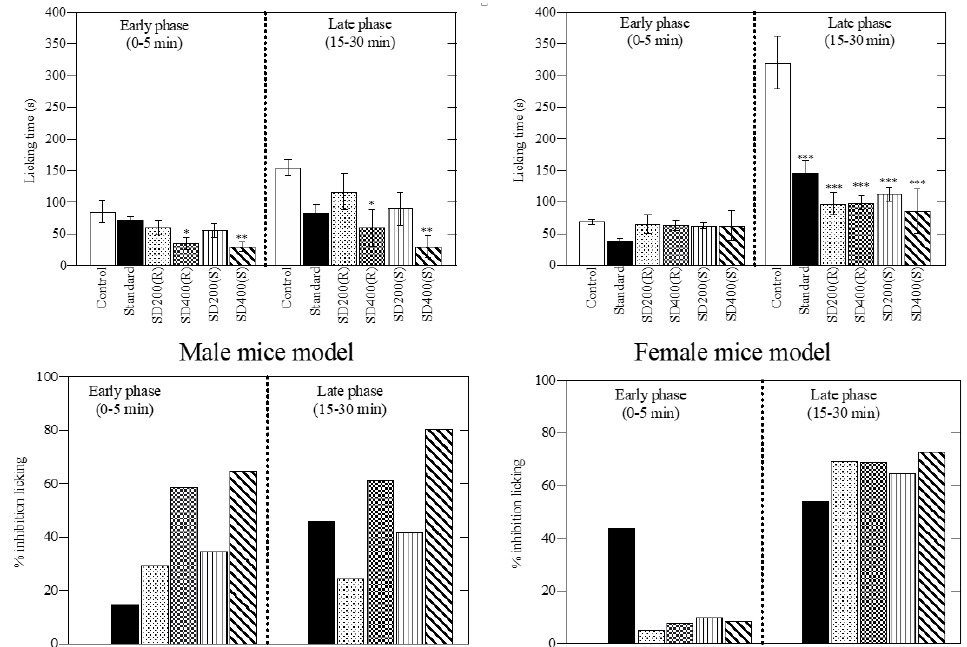
Figure 1. Effect of rhizome and stem extract of Schumannianthus dichotomus in formalin induced hind paw licking test in male and female mice model. Data were presented as Mean ± SEM. One-way ANOVA with Dunnett multiple comparisons test was performed to determine statistical significance of test results; here, *p<0.05, **p<0.01 and ***p<0.001 vs control. Table I. Effect of methanol extract of rhizome and stem of S. dichotomus on the number of writhing responses in acetic acid induced writhing test.